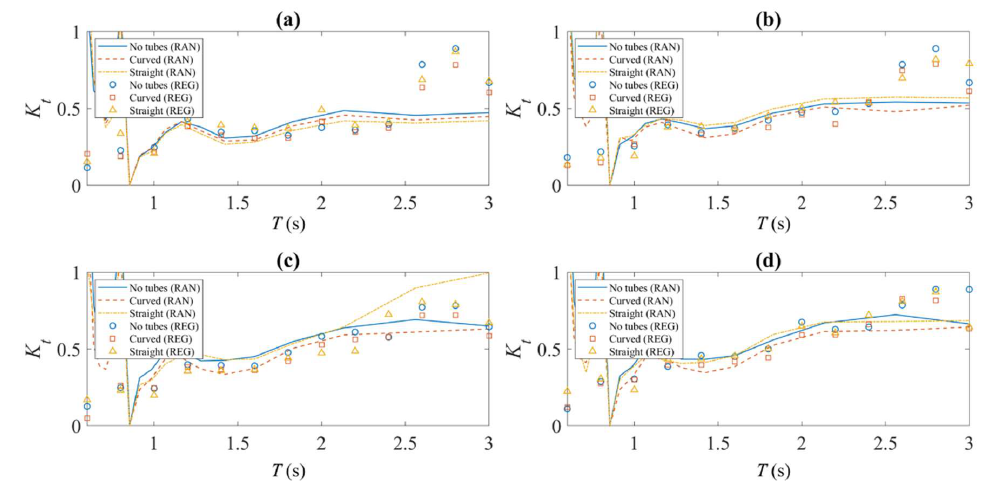
Figure 7. Transmission coefficients for various drafts ( a ) d = 0.42 m; ( b ) d = 0.37 m; ( c ) d = 0.32 m; ( d ) d = 0.27 m for a given wave height H = 0.06 m.